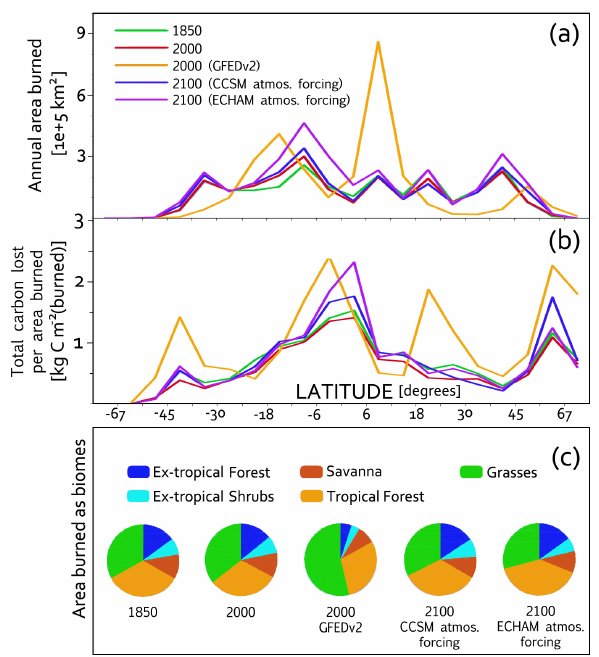
Fig. 3. A plot by latitude of (a) the annual total area burned for each 10-yr emissions period and (b) the amount of C released per area burned, and (c) a breakdown of the global annual average area burned into biomes defined by the CLM3 PFTs database for the respective time periods. Line and pie graph labels indicate the rep- resentative year and atmospheric forcing (for future simulations) for the CLM3 modeled fires, and, where labeled, the GFEDv2 present day fires. Note that the latitude bands each contain approximately the same surface area for better comparison of the total area burned across